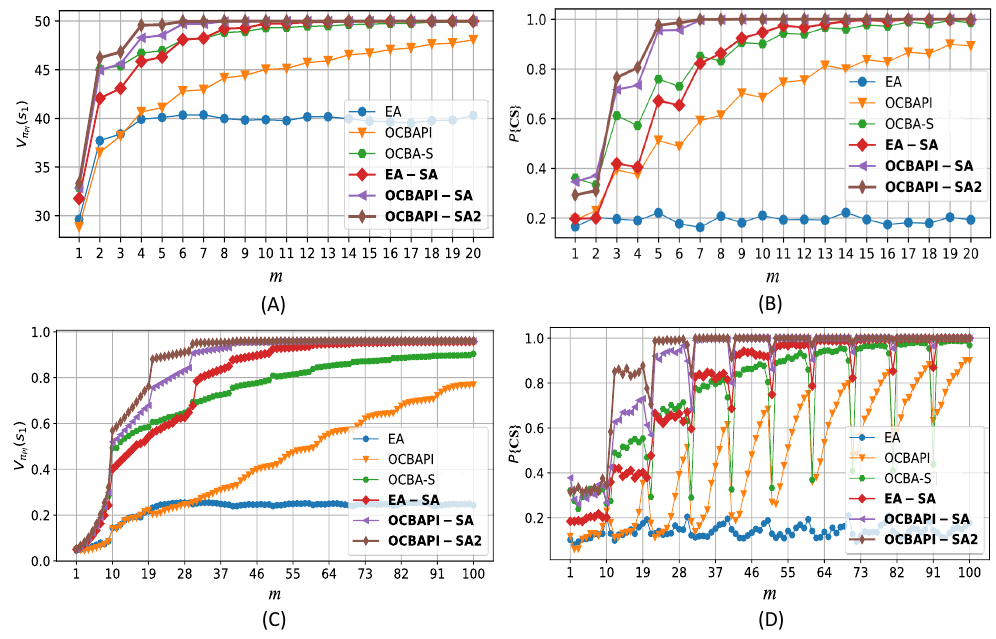
Figure 5. Graphs indicate the value function of the improved policy and P { CS } of each method for the two examples: ( A , B ) the results of the two-state example; ( C , D ) the results of the extended